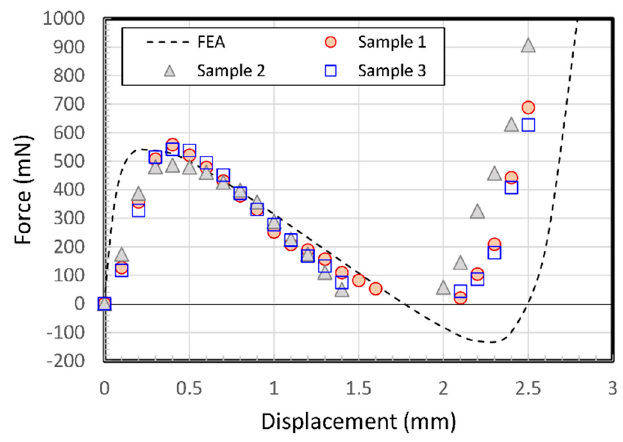
Figure 13. Double V-beam structure made by stacking up two molded single V-beam parts.